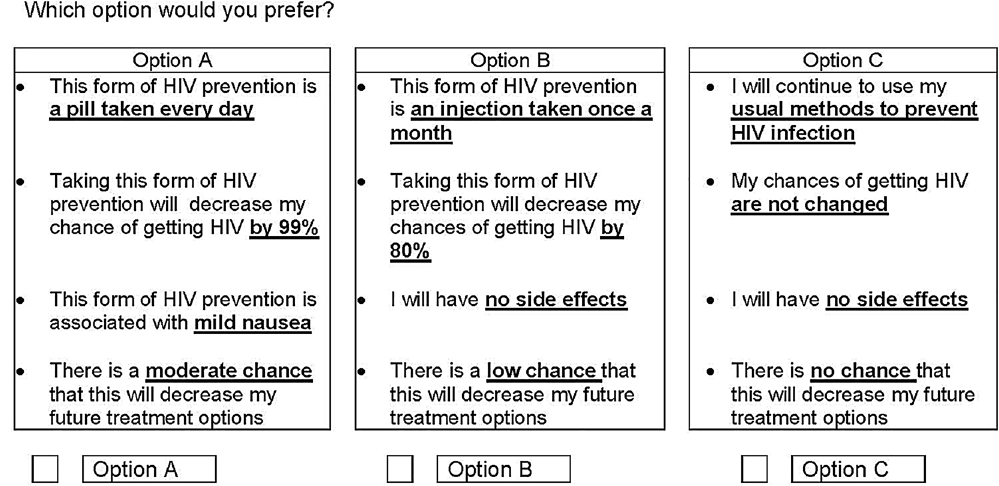
Figure 1. Example DCE choice set. Caption: Participants were presented with 12 such choice sets and selected one option from each set of three. Each choice set varied in terms of the PrEP formulation, the efficacy for HIV prevention, potential for mild side effects, and chance of decreasing future treatment